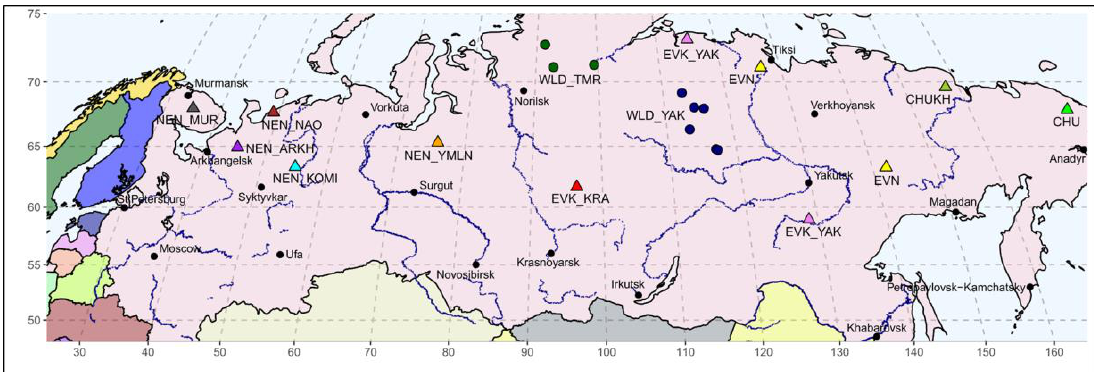
Figure 1. A geographical distribution of the sampled domestic and wild reindeer individuals on a map of Russia. CHU, Chukotka; CHUKH, Chukotka–Khargin; EVN, Even; EVK_YAK, Evenk of the Yakutia region; EVK_KRA, Evenk of the Krasnoyarsk region; NEN_YMLN, Nenets of the Yamalo-Nenets Autonomous district; NEN_NAO, Nenets of the Nenets Autonomous district; NEN_KOMI, Nenets of the Komi Republic; NEN_ARKH, Nenets of the Arkhangelsk region; NEN_MUR, Nenets of the Murmansk region; WLD_YAK, wild reindeer of Northern Yakutia; WLD_TMR, wild reindeer of Western Taymyr.